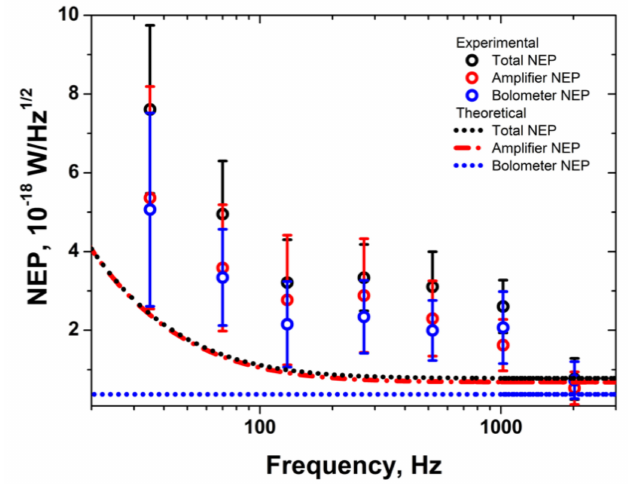
Figure 3. The total NEP, bolometer NEP and NEP due to the amplifier (open circles) compared to the theoretical predictions for varying modulation frequencies. The dashed line represents the value of the NEPs as predicted by